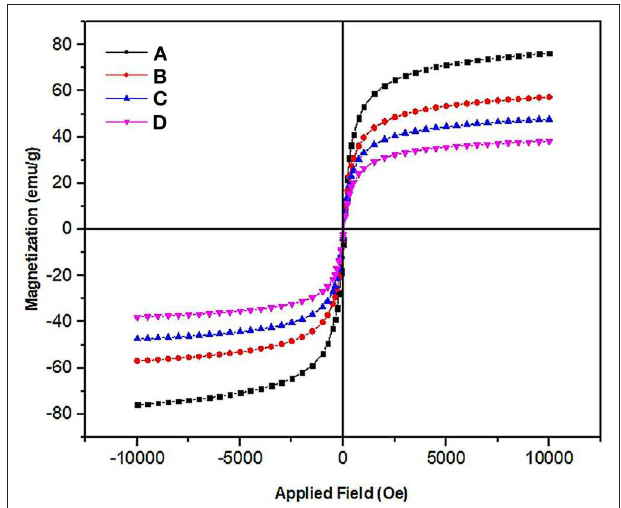
FIGURE 4 | VSM diagram of the (A) Fe 3 O 4 , (B) Fe 3 O 4 @SiO 2 , (C) Fe 3 O 4 @OS, and (D) Fe 3 O 4 @OS-SO 3 H